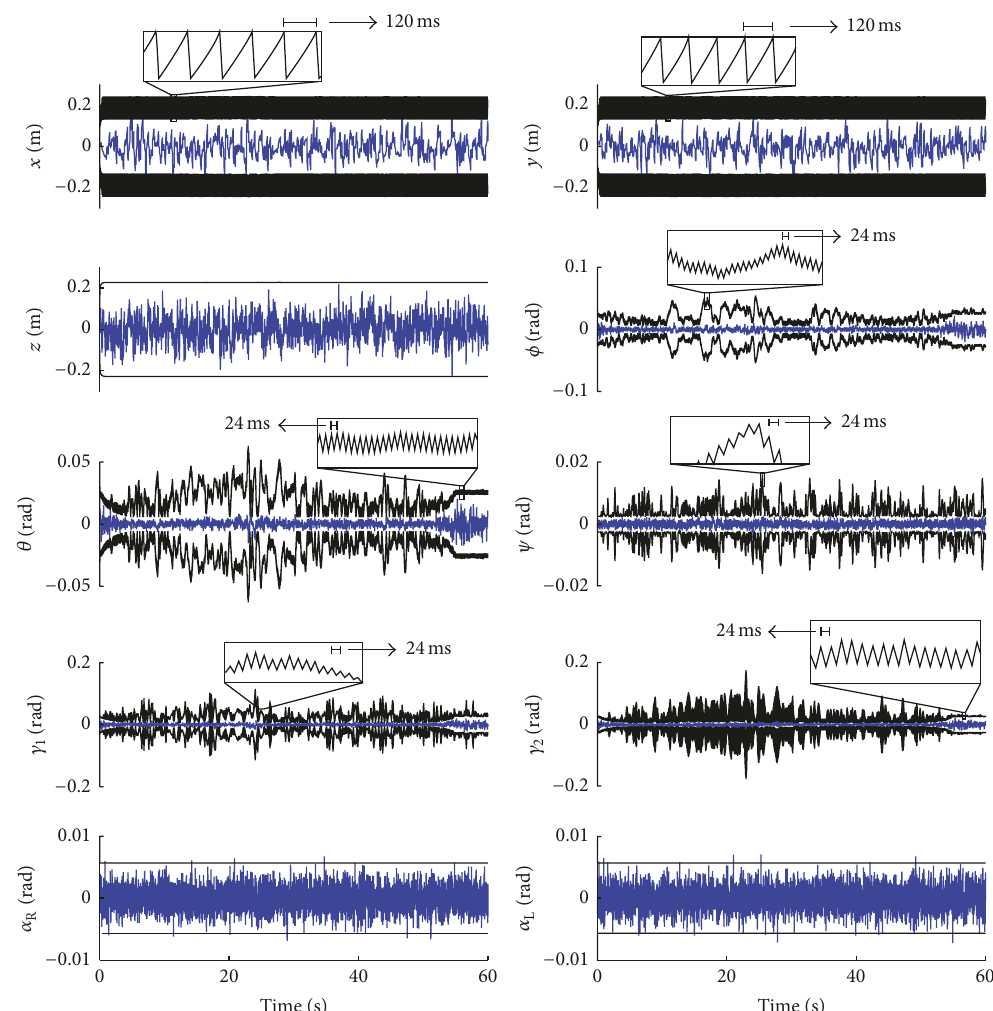
Figure 12: Time evolution of the estimation error of the generalized coordinates, along with the confidence limits. Patterns are highlighted to illustrate the estimation behavior in presence of different sampling